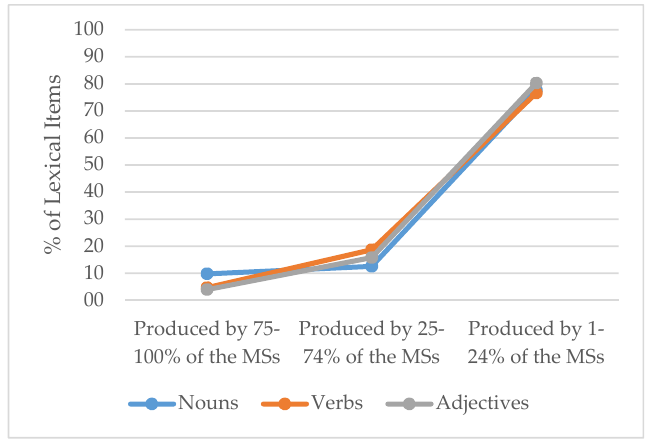
Figure 5. Distribution of word frequency per grammatical category in the monolingual group.